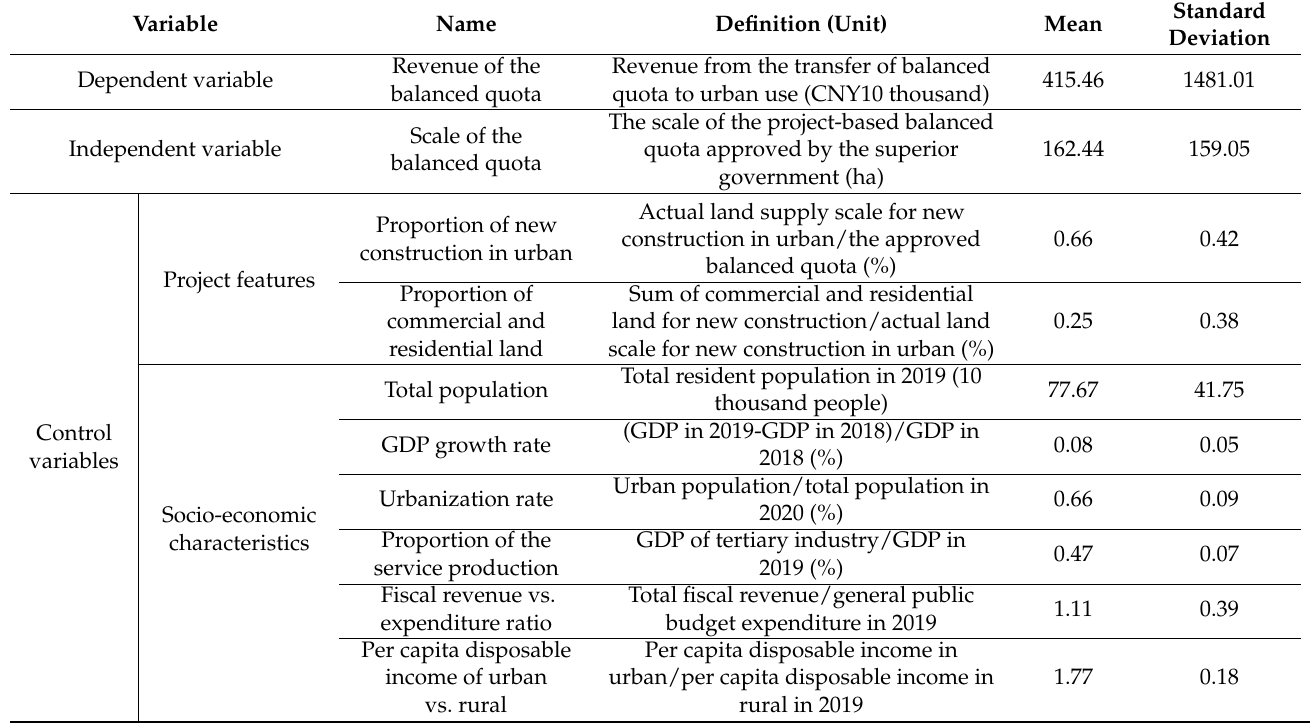
Table 1. Variable definitions and descriptive